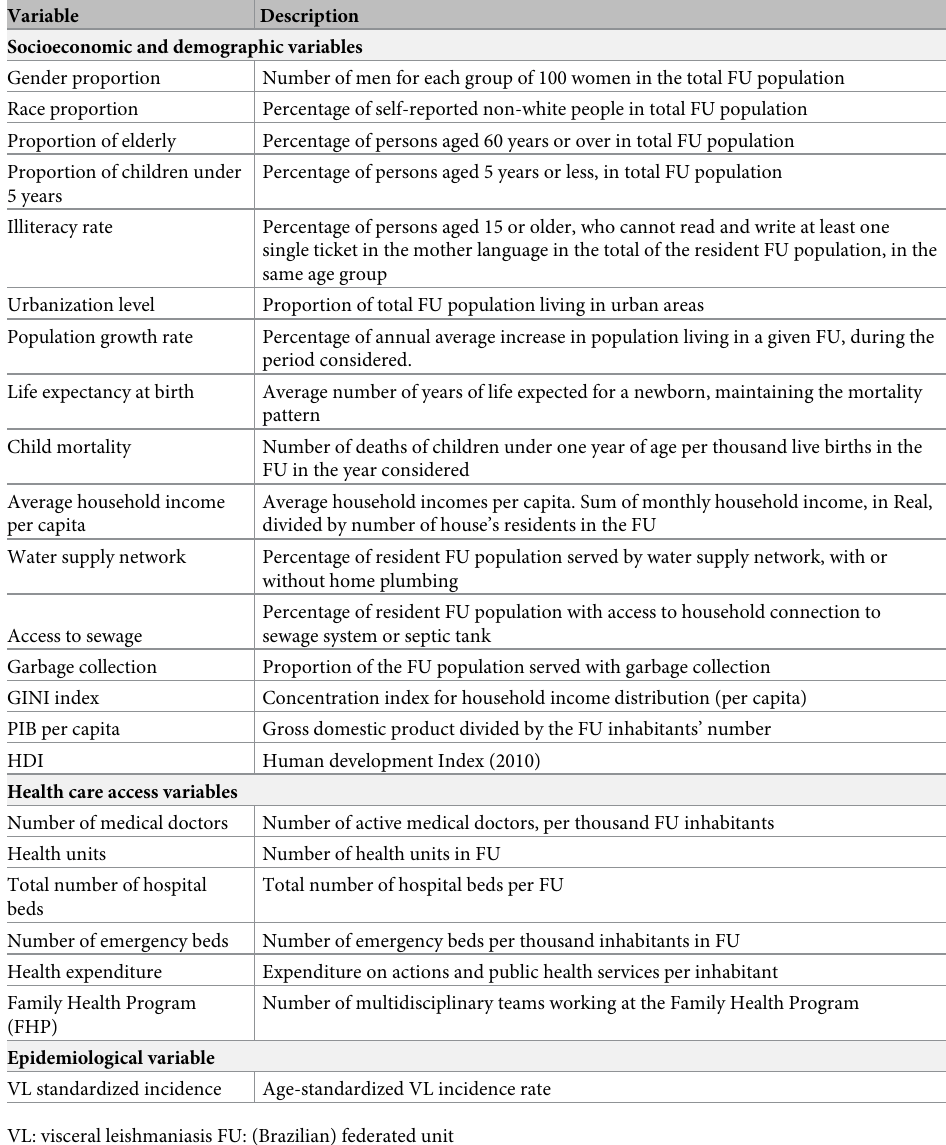
Table 2. Potential contextual risk factors for VL case-fatality explored at FU level (demographic, socioeconomic, health access and epidemiological indicators set for each Brazilian